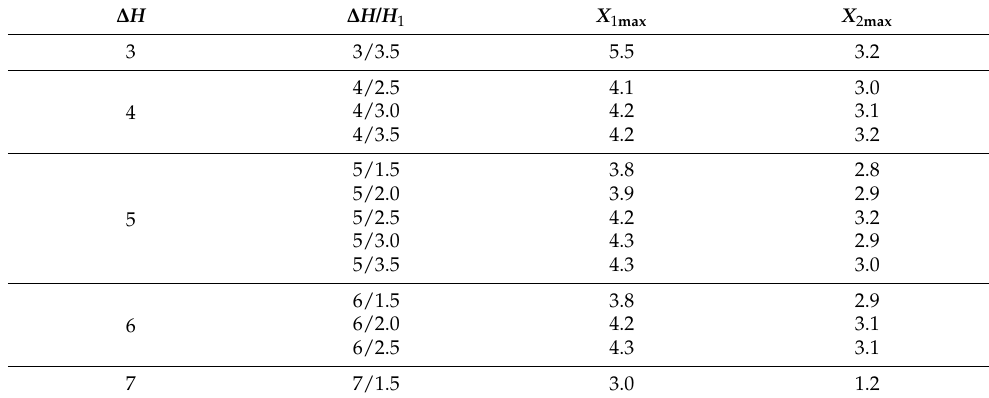
Table 6. Maximum horizontal displacement of panel (Unit: cm).